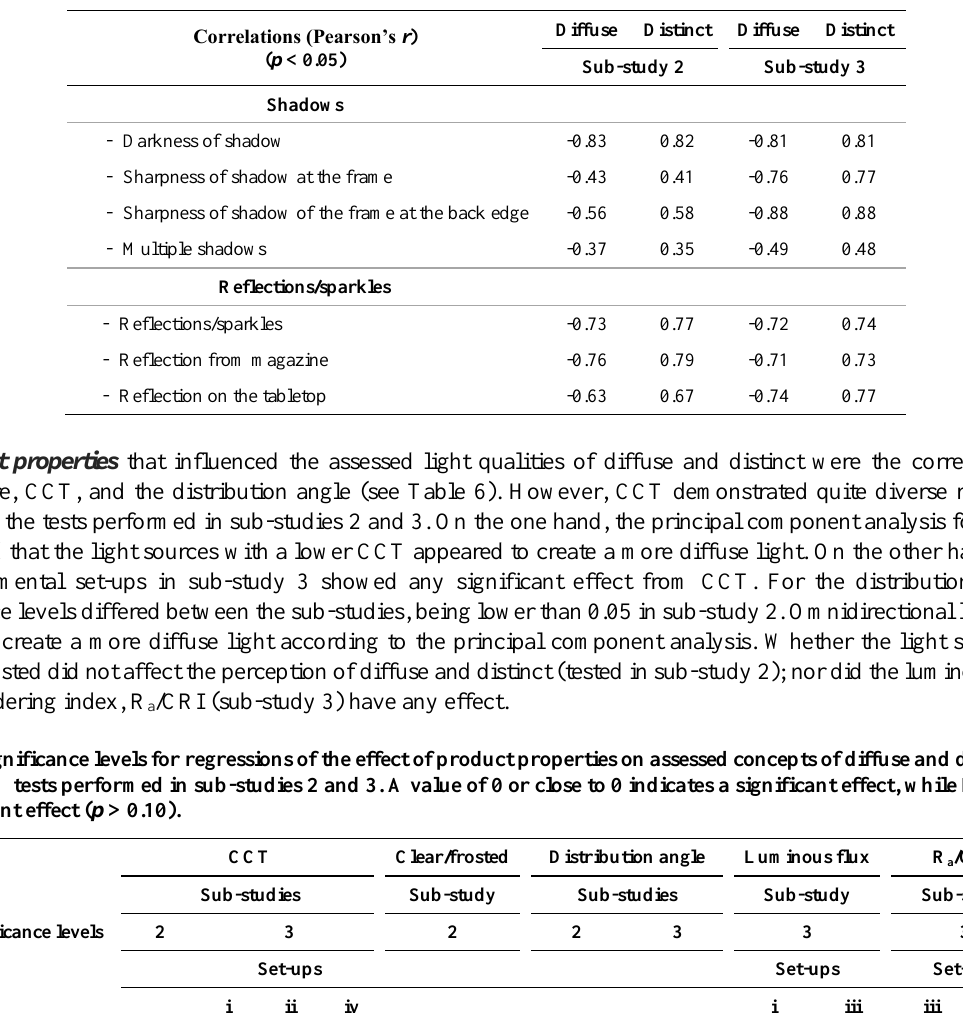
Table 5. Correlations for diffuse and distinct light with shadows and reflections/sparkles, results from tests performed in